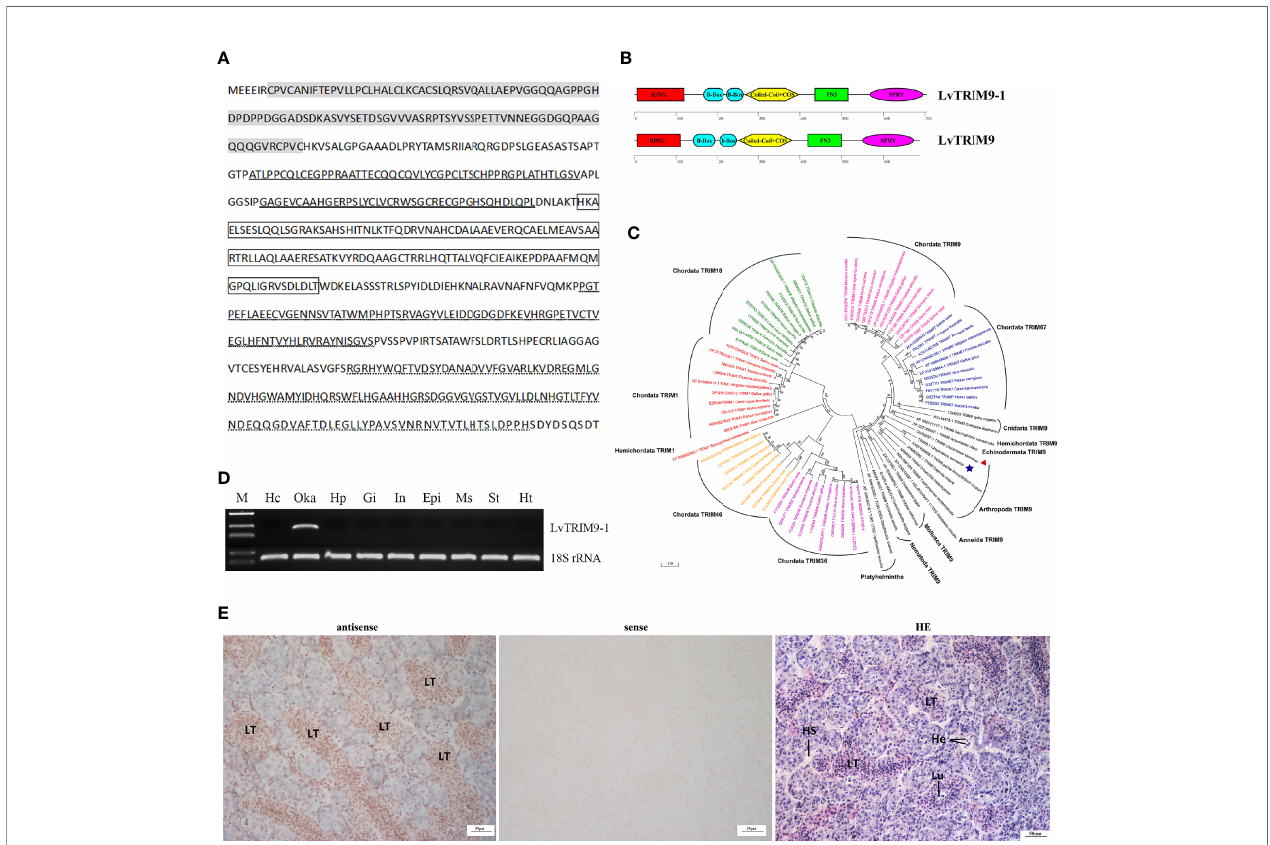
FIGURE 1 | Sequence information and tissue expression pattern of LvTRIM9-1 . (A) Deduced amino acid sequence of LvTRIM9-1. The RING domain was marked in gray. B-Box domains were bolded underlined. Coiled-coil and COS domains were marked in box. The FN3 domain was waved underlined. The SPRY domain was dotted underlined. (B) Schematic diagrams of LvTRIM9-1 and LvTRIM9. The RING, B-box, Coiled-coil, COS, FN3, and SPRY domains are illustrated. (C) Phylogenetic analysis of Class I TRIM proteins across animal phyla based on protein sequences. Different TRIM proteins were classi fi ed into seven branches shown with different colors (green, Chordata TRIM18; red, Chordata and Hemichordata TRIM1; yellow, Chordata TRIM46; purple, Chordata TRIM36; blue, Chordata TRIM67; pink, Chordata TRIM9; black, TRIM9 in non-vertebrate animal phyla). LvTRIM9 was marked with a red triangle, and LvTRIM9-1 was marked with a blue fi ve-pointed star. The TRIMs were shown with UniprotKB/Swiss-Prot or GenBank accession numbers listed in Table S2 . The neighbor-joining phylogenetic tree was built by MEGA 6, with bootstrap of 1000. (D) Expression patterns of LvTRIM9-1 in different tissues of L. vannamei . The 18S rRNA gene was used as the internal reference. Hc, hemocytes; Oka, lymphoid organ; Hp, hepatopancreas; Gi, gill; In, intestine; Epi, epidermis; Ms, muscle; St, stomach; Ht, heart. (E) Localization of LvTRIM9-1 transcripts in lymphoid organ of L. vannamei . Hematoxylin – eosin (H&E) staining (HE) and sense probe (sense) were used as control of the antisense probe hybridization